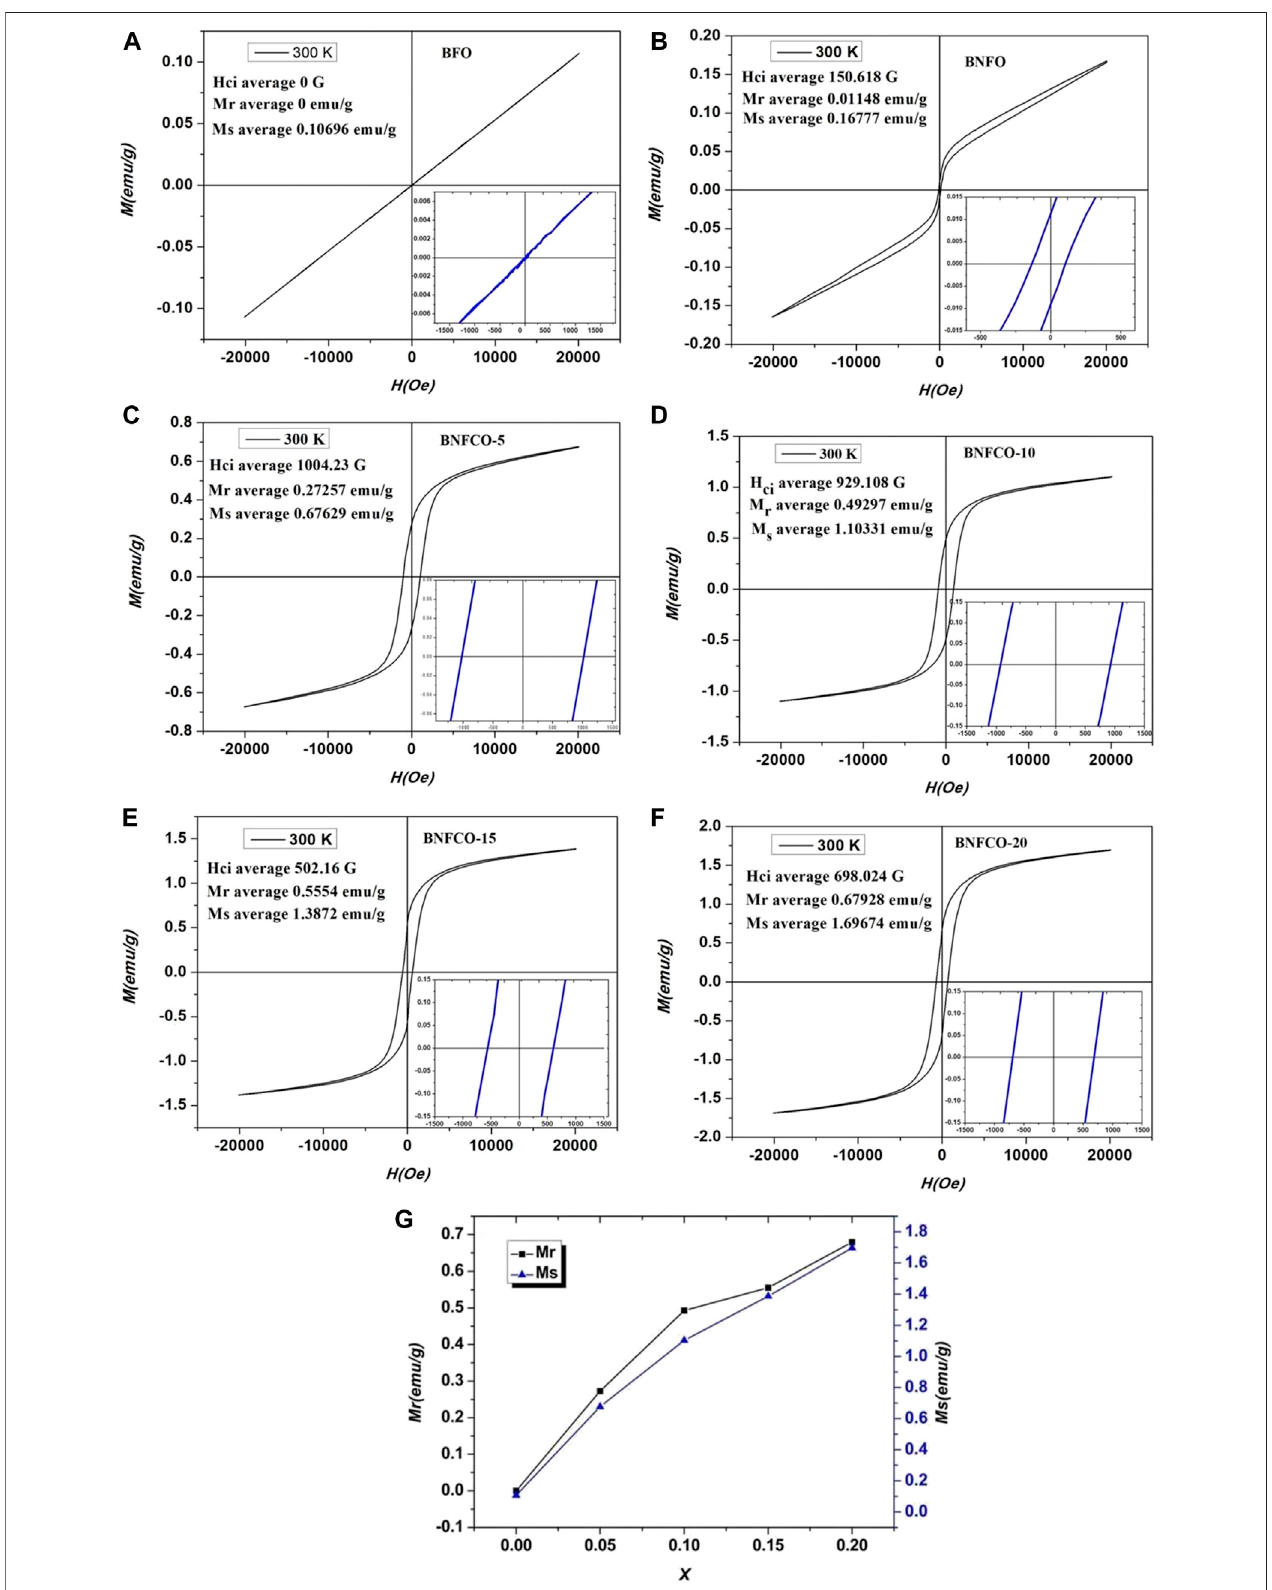
FIGURE 7 | M-H loops of the ceramics at room temperature: (A) BFO, (B) BNFO, (C) BNFCO-5, (D) BNFCO-10, (E) BNFCO-15, (F) BNFCO-20, (G) The substituted concentration dependences of M r and M s .